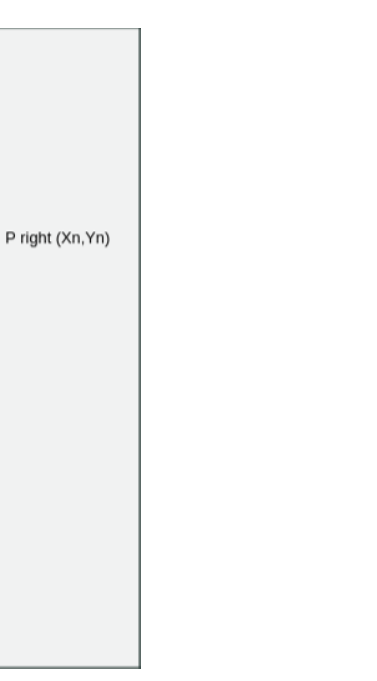
Figure 1. A demonstration of λ f calculation by searching the maximal distance between two vertices of the